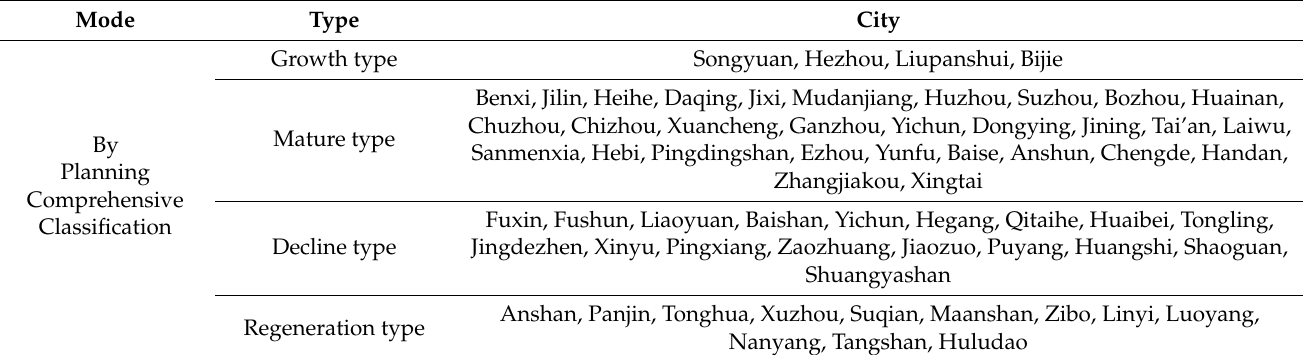
Table 1. Regional classification of resource-based